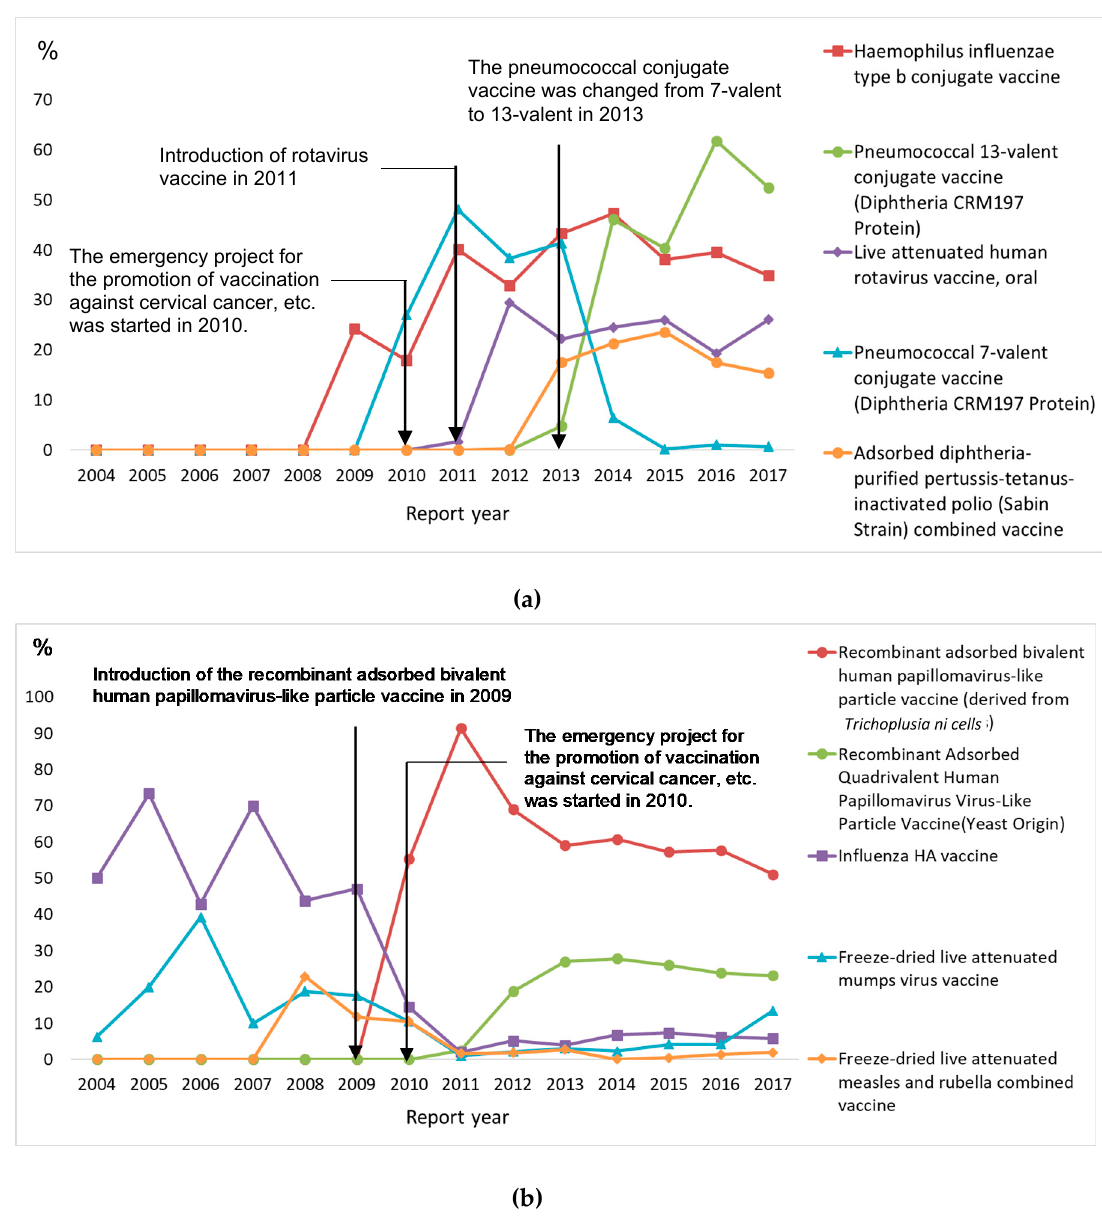
Figure 2. Time trend of the five most frequently reported vaccines according to age group. ( a ) Children < 10 years old. ( b ) Children 10–19 years old.